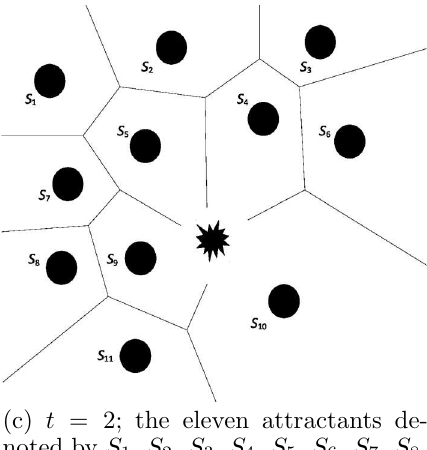
Figure 6. Example of propagation of parasites. First of all, parasites are located in the center of pictures (a), (b), (c). Attractants which are not occupied by parasites are denoted by white circles. Attractants which are occupied by parasites are denoted by black circles. Each attractant is the center of a suitable Voronoi cell. The radius of Voro- noi cell is a maximal distance of power to attract parasites in one direction. At time t = 0 , 1 , 2 , different syllogistic propositions are true: (a) S 7 i 0 S 11 , S 11 i 0 S 7 , S 1 i 0 S 3 , S 3 i 0 S 1 , S 1 e 0 S 10 , S 10 e 0 S 1 , S 1 e 0 S 9 , S 9 e 0 S 1 , S 1 e 0 S 4 , S 4 e 0 S 1 , etc.; (b) S 1 i 1 S 11 , S 11 i 1 S 1 , S 2 o 1 S 6 , S 6 o 1 S 2 , etc.; (c) S 7 a 2 S 11 , S 11 a 2 S 7 , S 1 a 2 S 3 , S 3 a 2 S 1 , S 1 a 2 S 10 , S 10 a 2 S 1 , S 1 a 2 S 9 ,